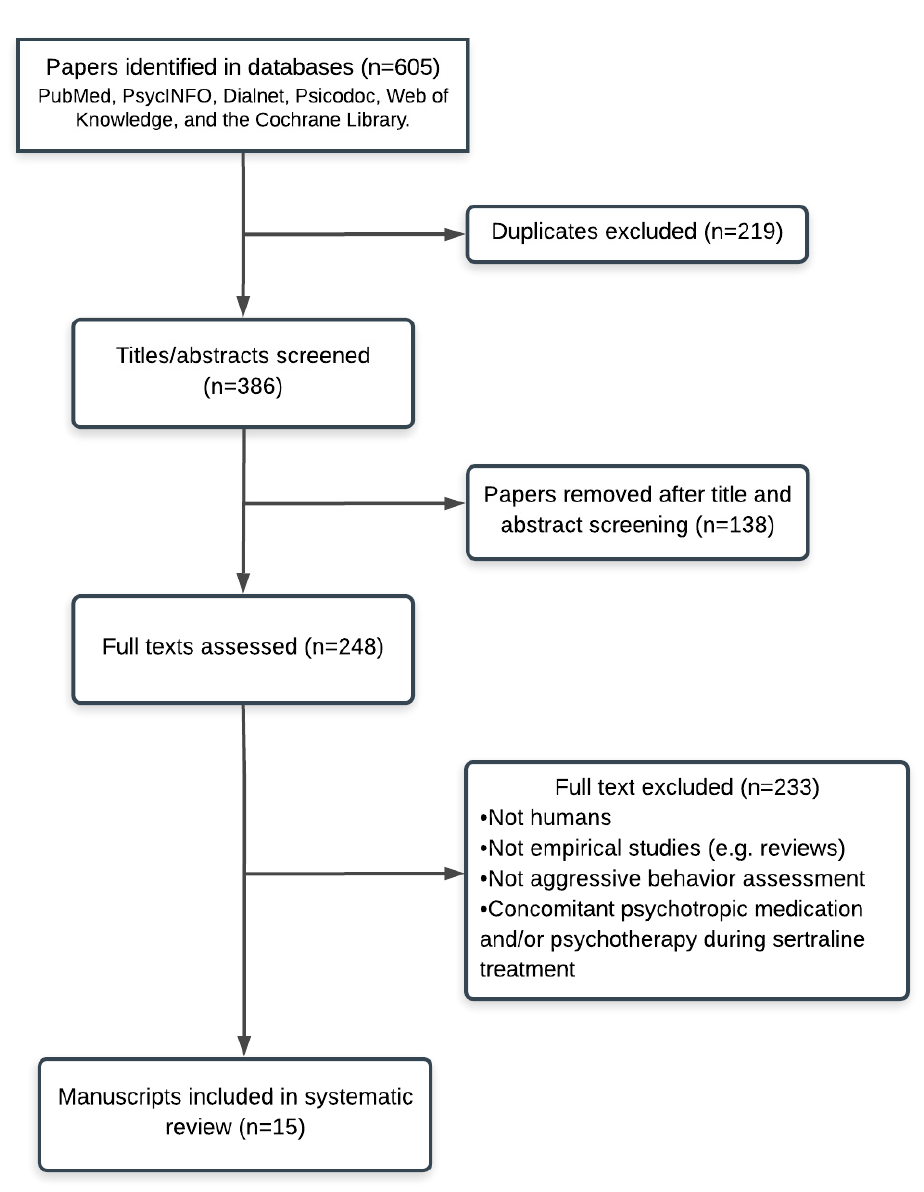
Figure 1. PRISMA flow chart of literature search with reasons for exclusion.